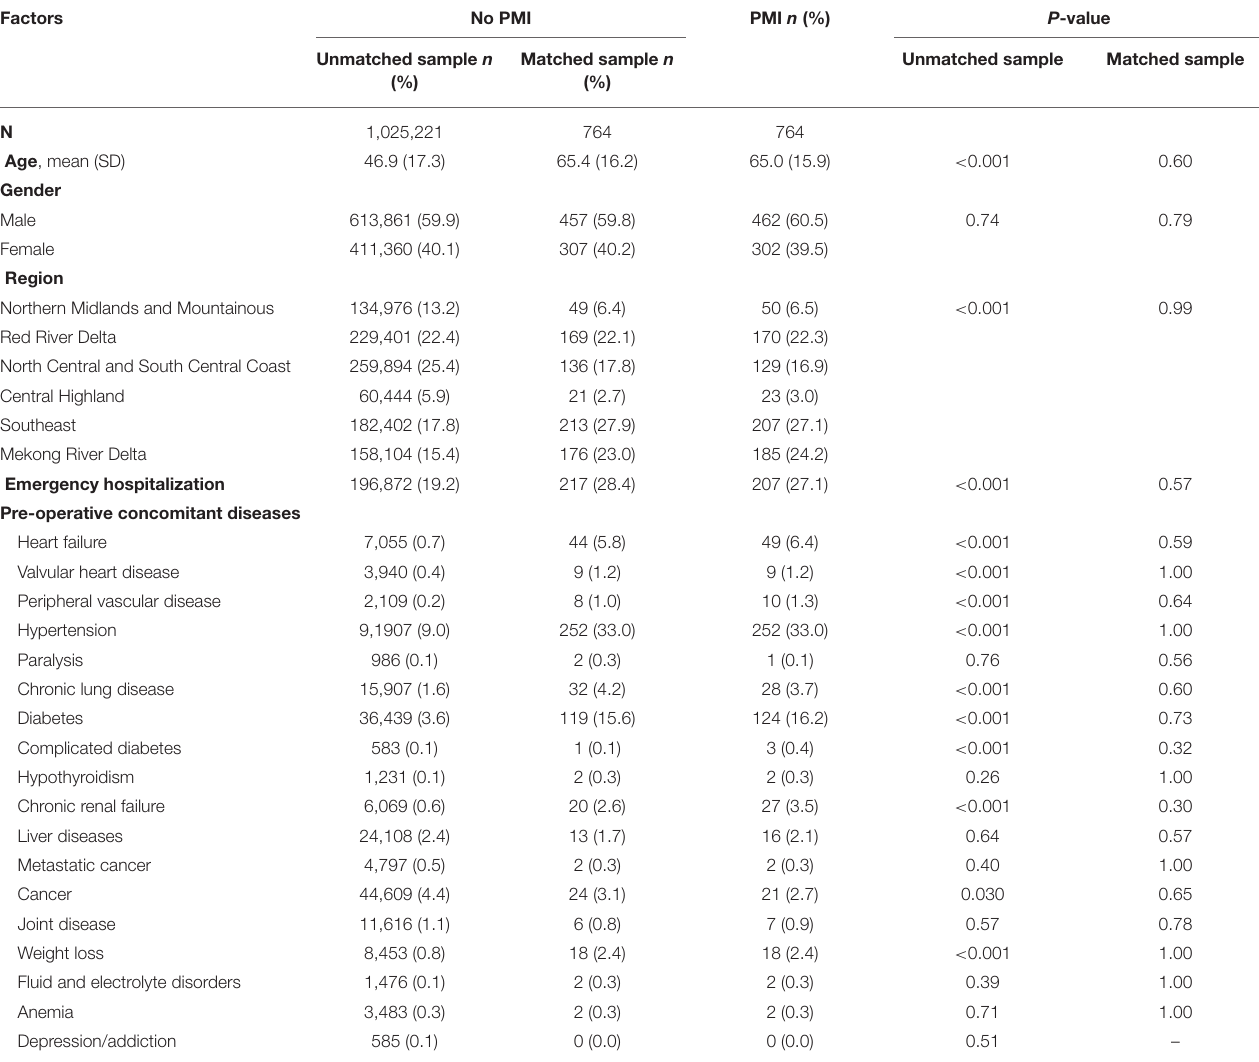
TABLE 1 | Baseline characteristics of surgical patients by myocardial infarction before and after matching.